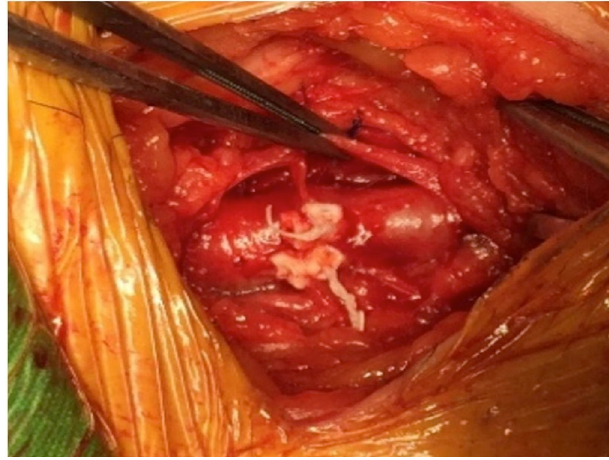
Fig. 3 - Appearance of the femoral artery and vein after tying the